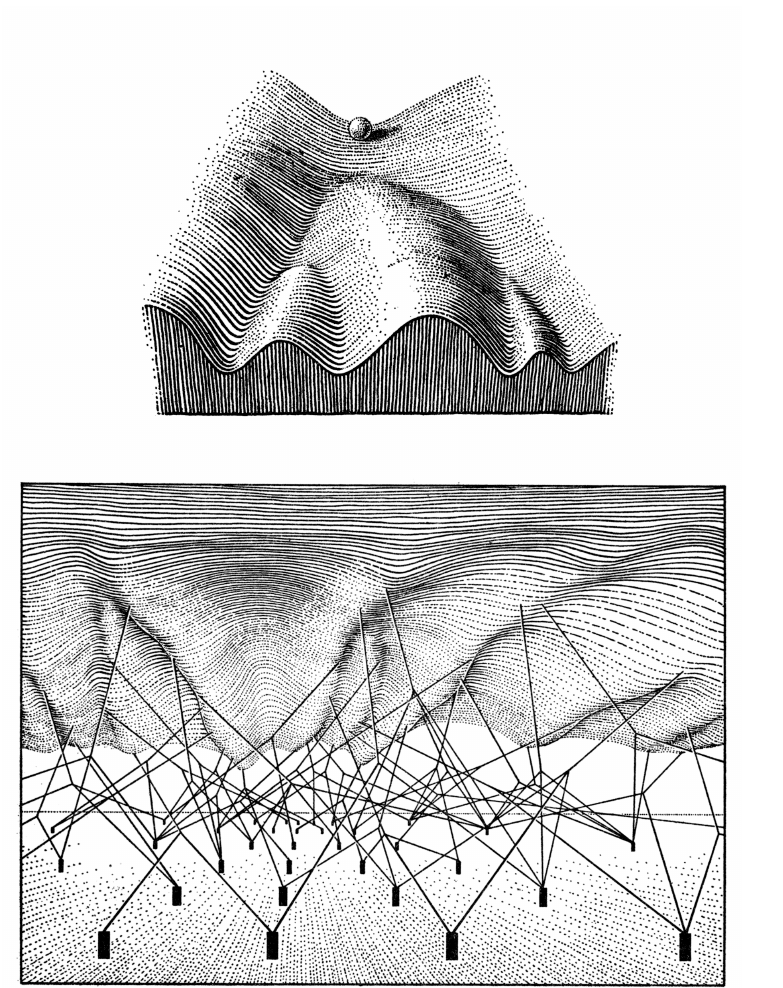
Part of an Epigenetic Landscape and The Complex System of Interactions Underlying the Epigenetic Landscape, from Conrad H. Waddington, The strategy of the Genes (London: Allen and Unwin, 1957),